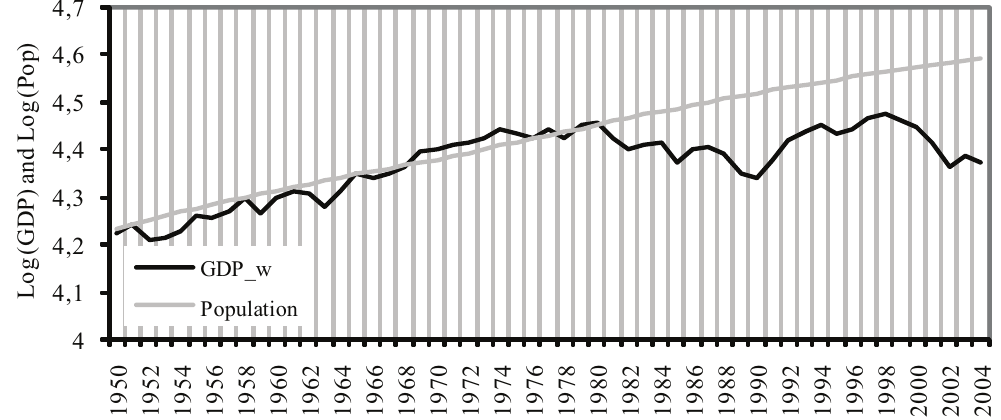
Fig. 1. Real GDP per worker in Argentina from 1950 to